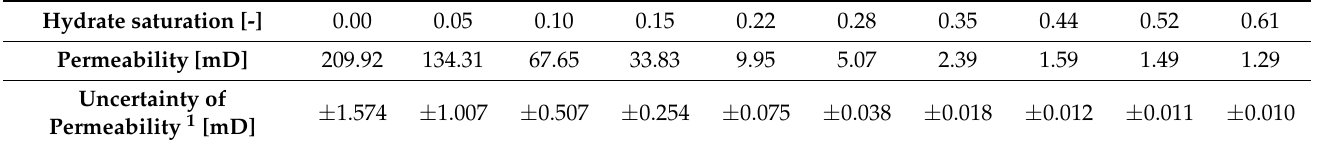
Figure 4. Permeability change with hydrate saturation: ( a ) experimental results (UBGH2-6); ( b ) comparison with experi- mental results in the literature. Table 2. Measured permeability data (porosity = 0.48).